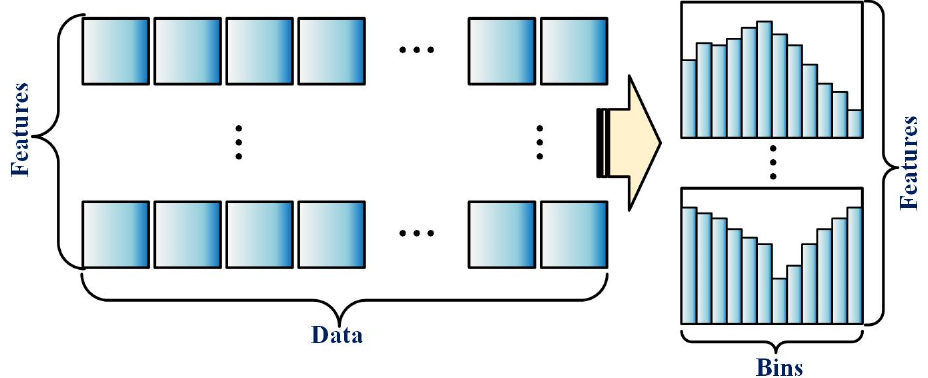
Figure 2. Schematic diagram to build the GBT model.